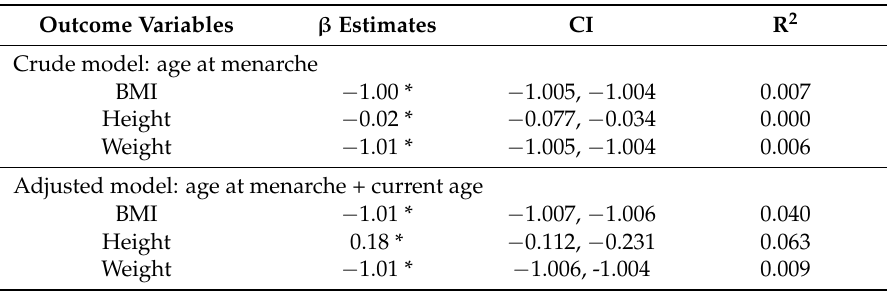
Table 2. Association between age at menarche and nutritional status.